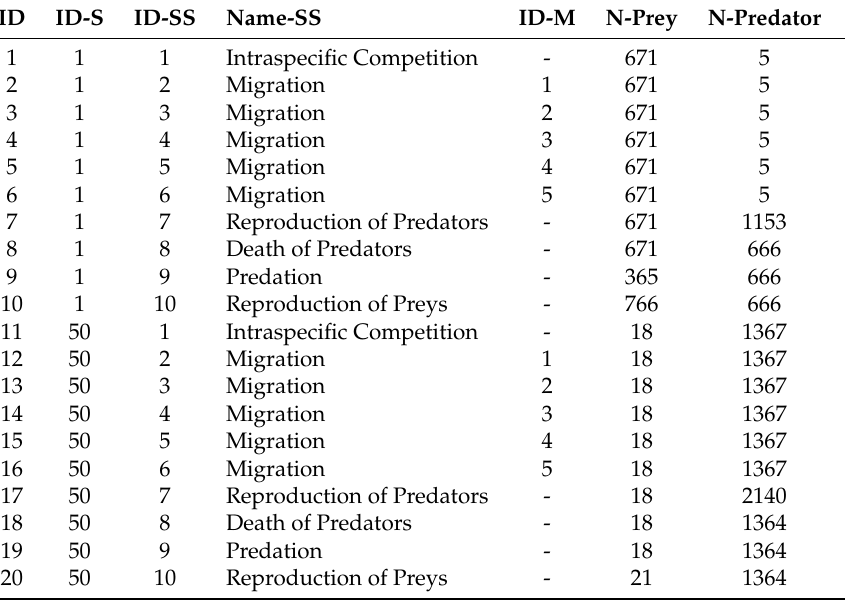
Table 6. Simulation carried out without using agents—Case